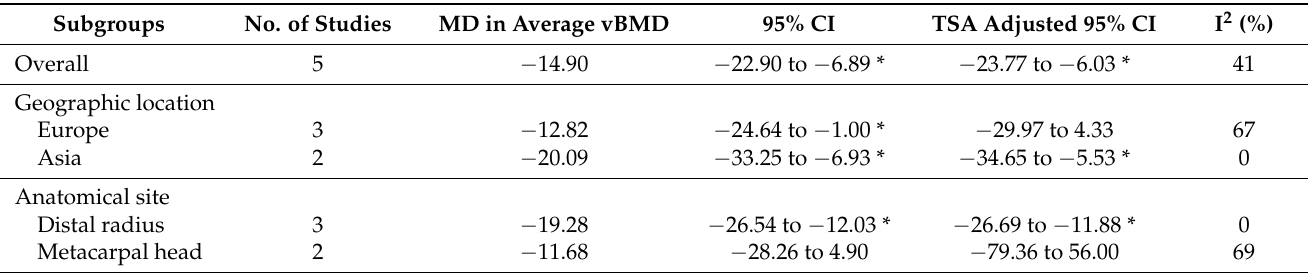
Table 2. Subgroup Table 2. Subgroup analysis.